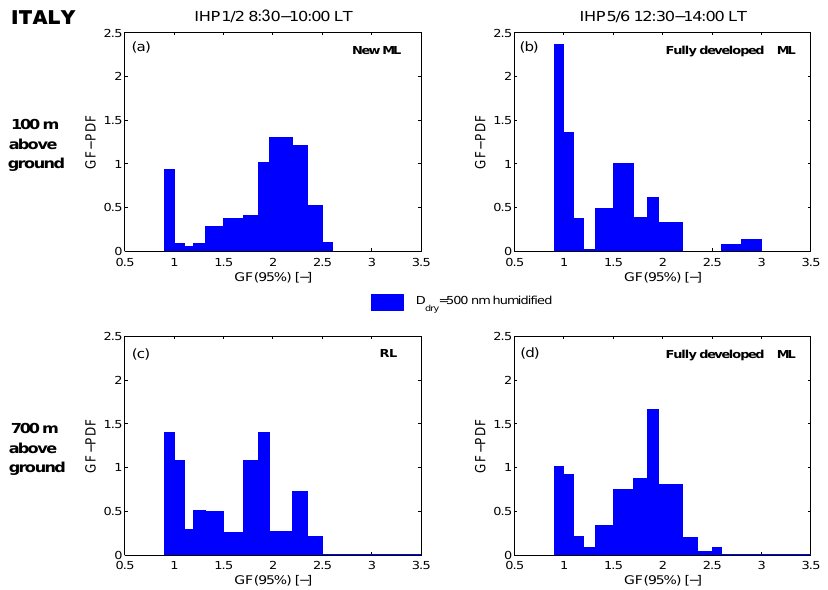
Figure 3. GF-PDFs during 20 June 2012 in Italy: profile IHP1/2 was flown between 08:30 and 10:00LT and IHP5/6 between ∼ 12:30 and 14:00LT; the blue area displays the GF-PDFs for a selected dry diameter of 500nm. (a, b) illustrate the results at approximately 100ma . g . l . and (c, d) for approximately 700ma . g .